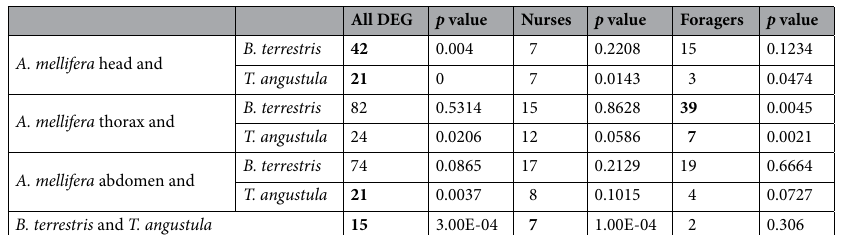
Table 1. Number of genes in common among the set of differentially expressed genes between nurses and foragers of B. terrestris , T. angustula and A. mellifera samples. Overlap p value of significance from random sampling is shown; significant overlaps are indicated in